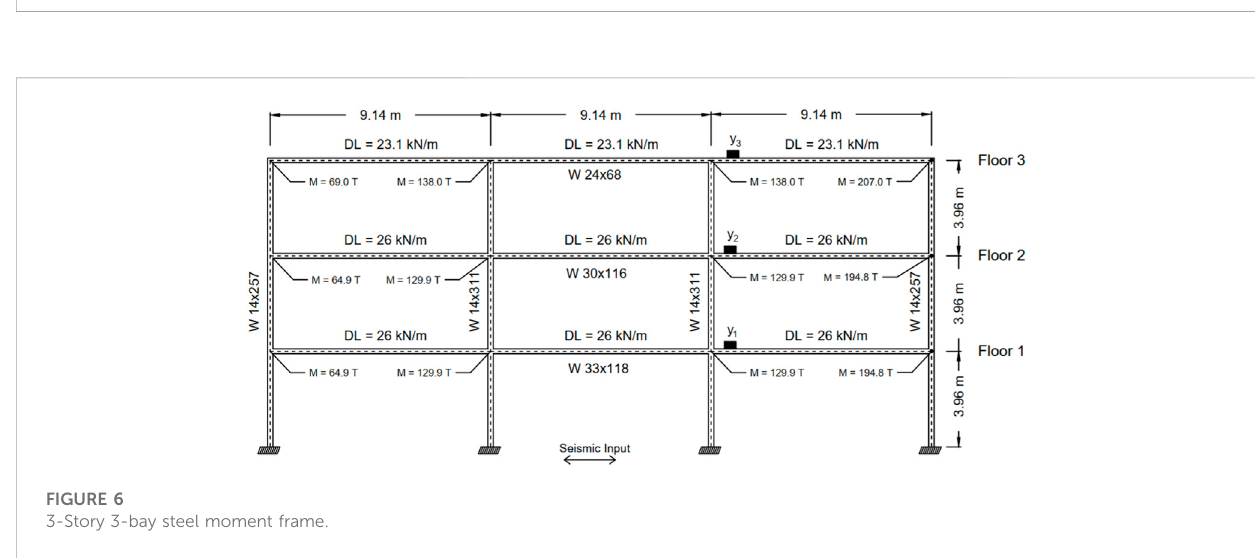
FIGURE 5 Timehistories oftheestimatedmodelparameters obtainedbythethreemethods:theproposed VBmethod,thetwo-step marginalMAPestimation method, and the non-adaptive Bayesian method.